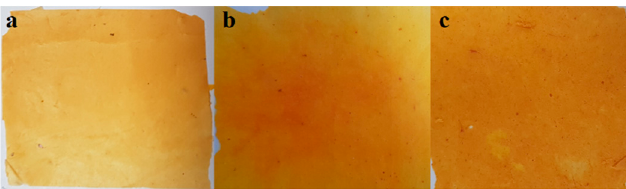
Figure 4. Electrospun Nanofibers of: ( a ) Electrospun SDIB/PBz with 0 % SDIB (ES ‐ SDIB/PBz ‐ 0); ( b ) ES ‐ SDIB/PBz ‐ 5; and ( c ) ES ‐ SDIB/PBz ‐ 10.